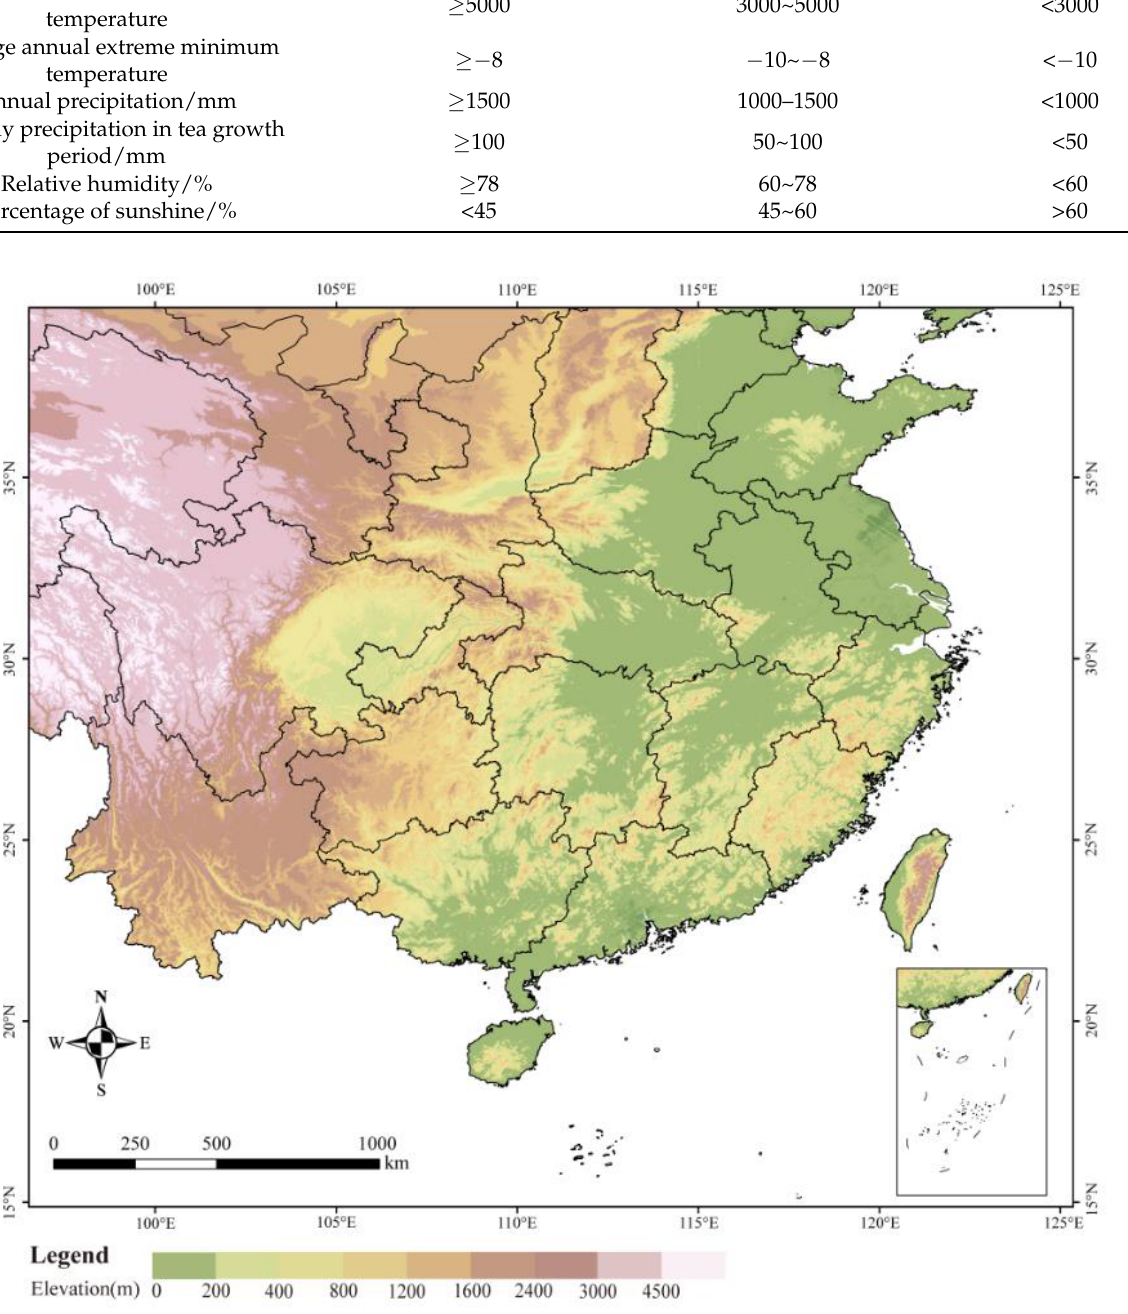
Figure A2. Variation of Tea Production Cities in Shandong Province. The red and blue points are the locations of recorded tea producing cities in 1987 and 2017 according to the statistical data, re- spectively.